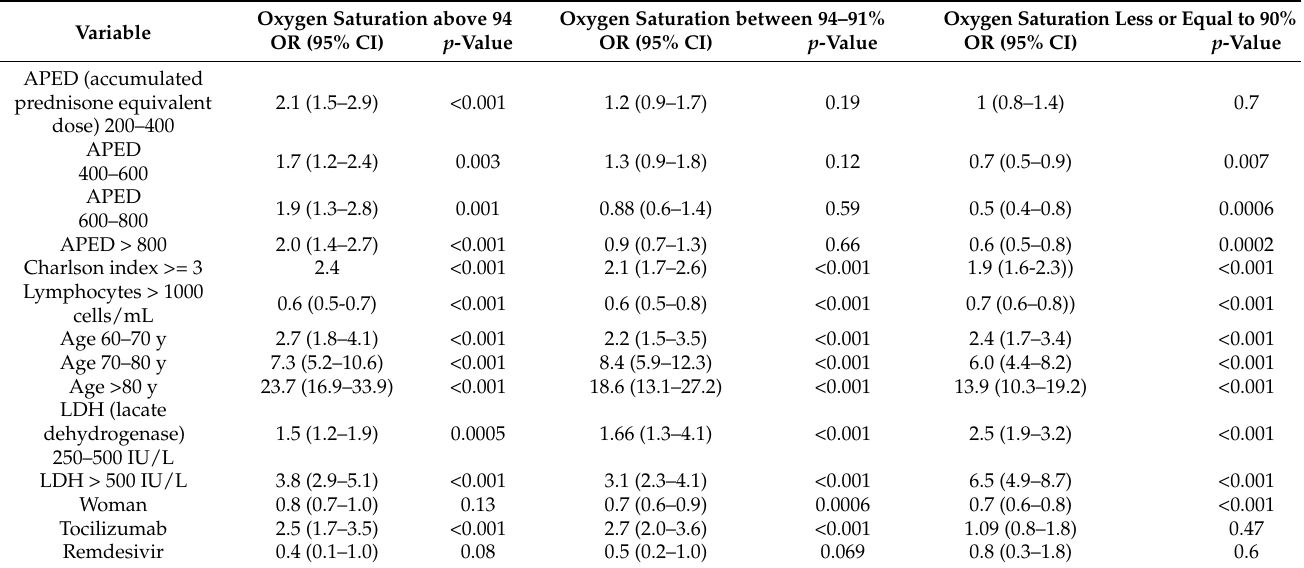
Figure 4. Mortality of patients by corticosteroid dose (accumulated prednisone equivalent dose) and oxygen saturation group. Table 3. Multivariate analysis with a logistic regression model by oxygen saturation group.